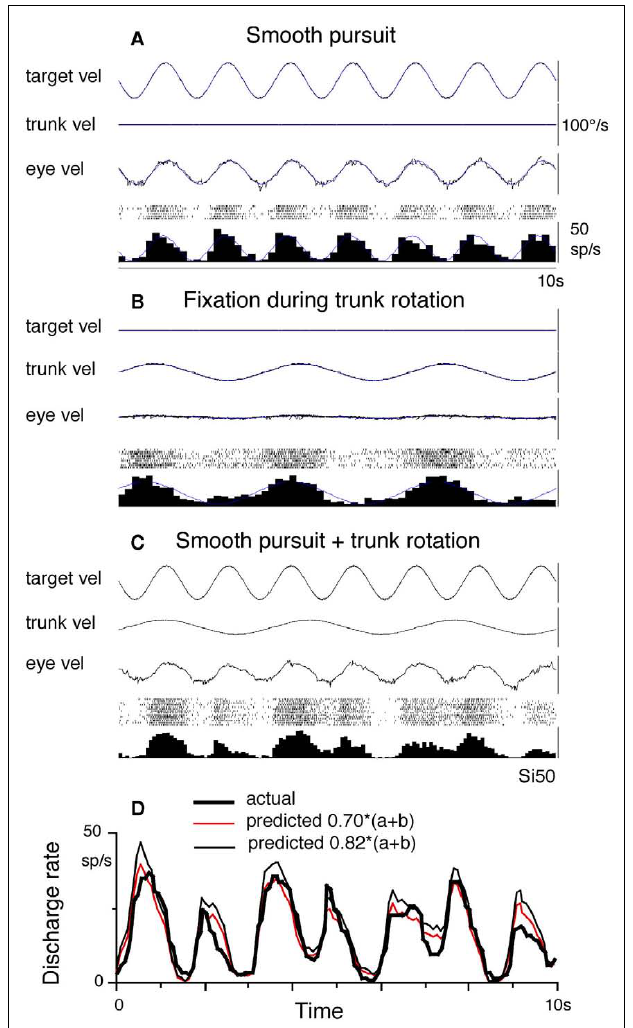
FIGURE 5 | Linear addition of smooth-pursuit and neck input related modulation. Discharge is shown for a representative FEF eye/head-velocity neuron. (A) Smooth-pursuit at 0.7Hz. (B) Passive trunk-on-head rotation at 0.3Hz while the monkey fixated a stationary spot in space. (C) The combination of the two stimuli. (D) Compares actual (thick line) and predicted modulation calculated by addition of modulation in (A,B) with a gain factor as indicated (red and thin black).Thin lines on averaged histograms of cell discharge in (A,B) are superimposed fit sine waves. Eye vel indicates de-saccaded and averaged eye velocity.Target vel and trunk vel indicate target velocity in space and trunk velocity in space. Reproduced from Fukushima et al. (2010) with permission.